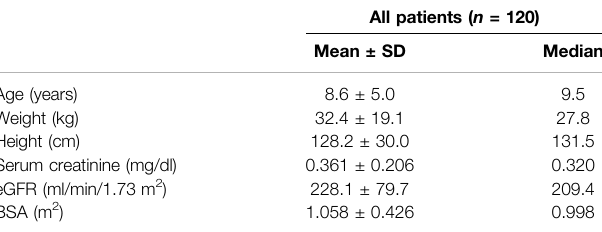
TABLE 1 | Characteristics of the 120 patients enrolled in the present study. There were not statistically signi fi cant differences between males and females. All patients ( n = 120)